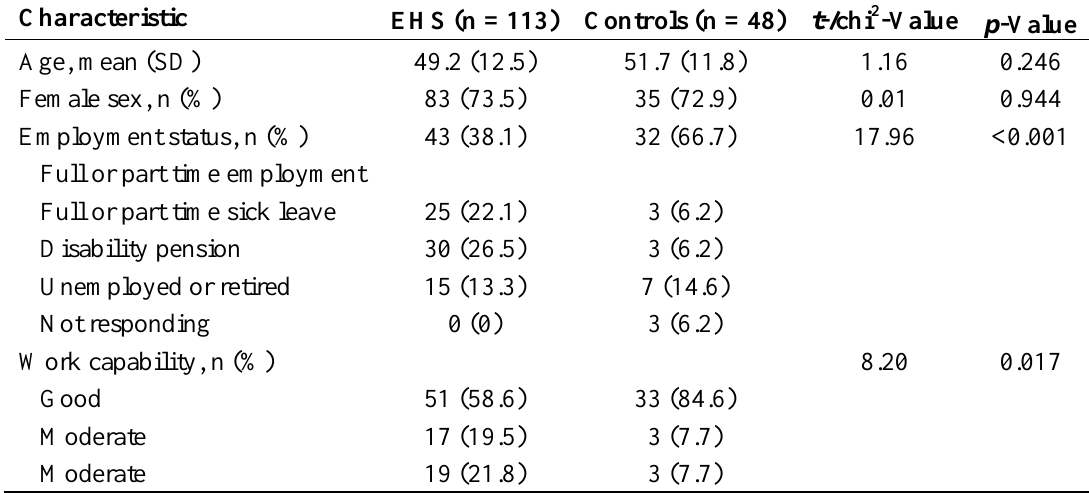
Table 2. Self-reported participant characteristics in the groups with electromagnetic hypersensitivity (EHS) and control